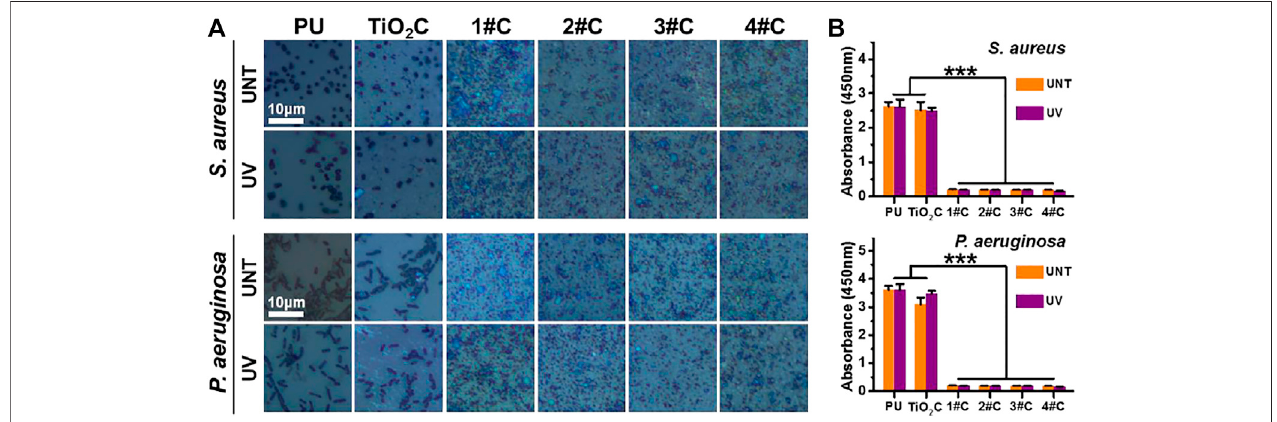
FIGURE 3 | Antibacterial activity assay. Optical microscopy images of bacteria cultured on nanoparticles coatings before and after photo-functionalization (A) and bacterial activity measured by CCK-8 kit (B)